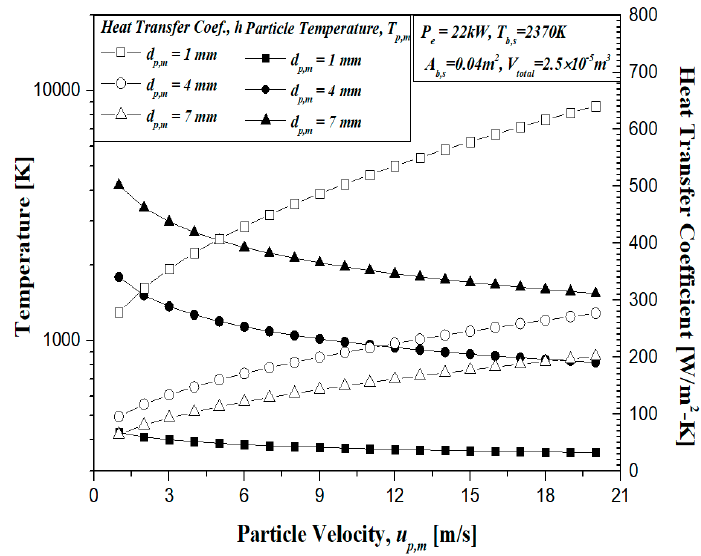
Figure 12. The e ff ects of particle temperature and convective heat transfer coe ffi cient on the particle velocity for d p , m = 1, 4, and 7 mm.